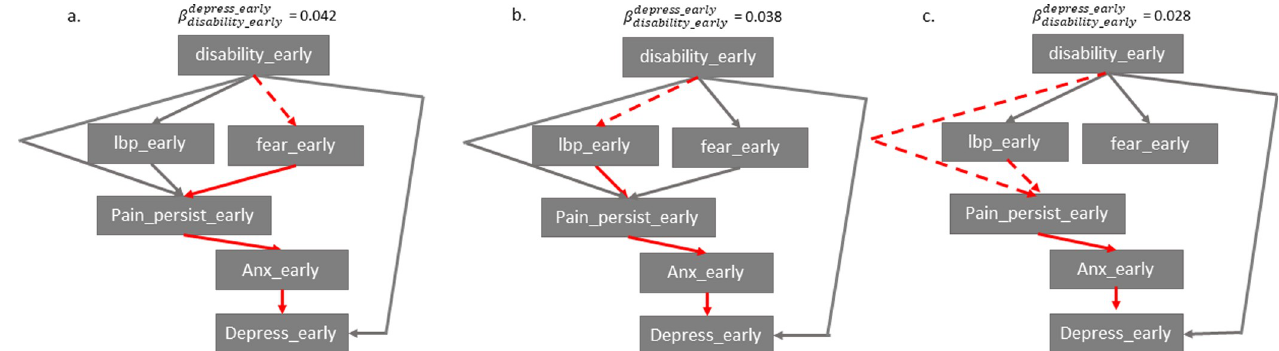
Fig 4. Contribution of different pathways from early change in disability to early change in depressive symptoms. A dotted arc (-— > ) reflects a simulation whereby the “child” variable was made independent of its “parent”, meaning it is removed. Arrows in red reflect the arcs which are “removed” as a consequence of the aforementioned simulation. Information can only pass through grey arcs (not red). (a) scenario where early change in fear was independent of early change in disability, (b) scenario where early change in persistence was independent of early change in disability and low back pain. Abbreviation: Suffix with “_early”–change score between baseline and week-10 follow-up; “_late”–change value between week-10 and week-52; Anx—anxiety; lbp–low back pain.